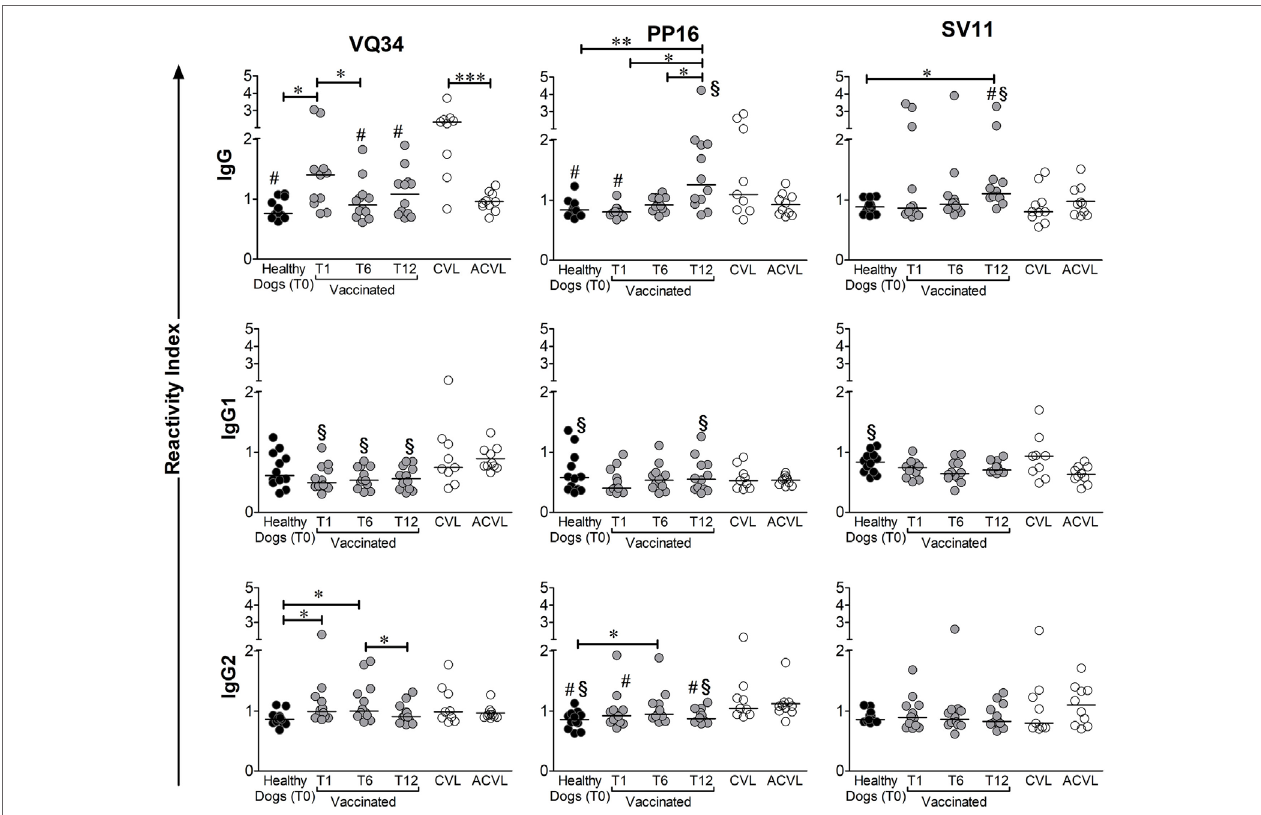
FigUre 3 | Medians of reactivity indexes of total IgG, IgG1, and IgG2 subclass against the three selected B peptides form A2 protein (VQ34, PP16, and SV11) detected in the serum of infected symptomatic canine visceral leishmaniasis dogs (CVL), infected asymptomatic dogs (ACVL), healthy controls (T0), and vaccinated dogs 1 (T1), 6 (T6) and 12 months (T12) after the end of immunization protocol. Wilcoxon’s paired non-parametric test was used to compare samples from healthy and immunized groups. The Mann–Whitney test was used to compare samples between vaccinated and CVL or healthy and CVL groups. # different from CVL, § different form ACVL. * p < 0.05, ** p < 0.005, *** p <